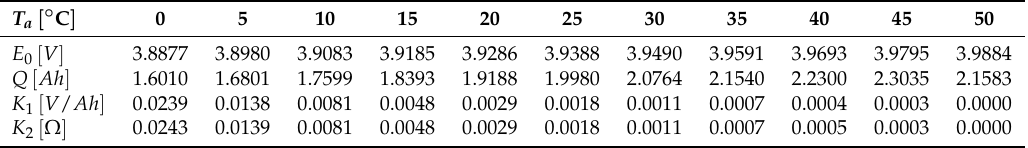
Table 5. Estimated battery parameters at different temperatures during